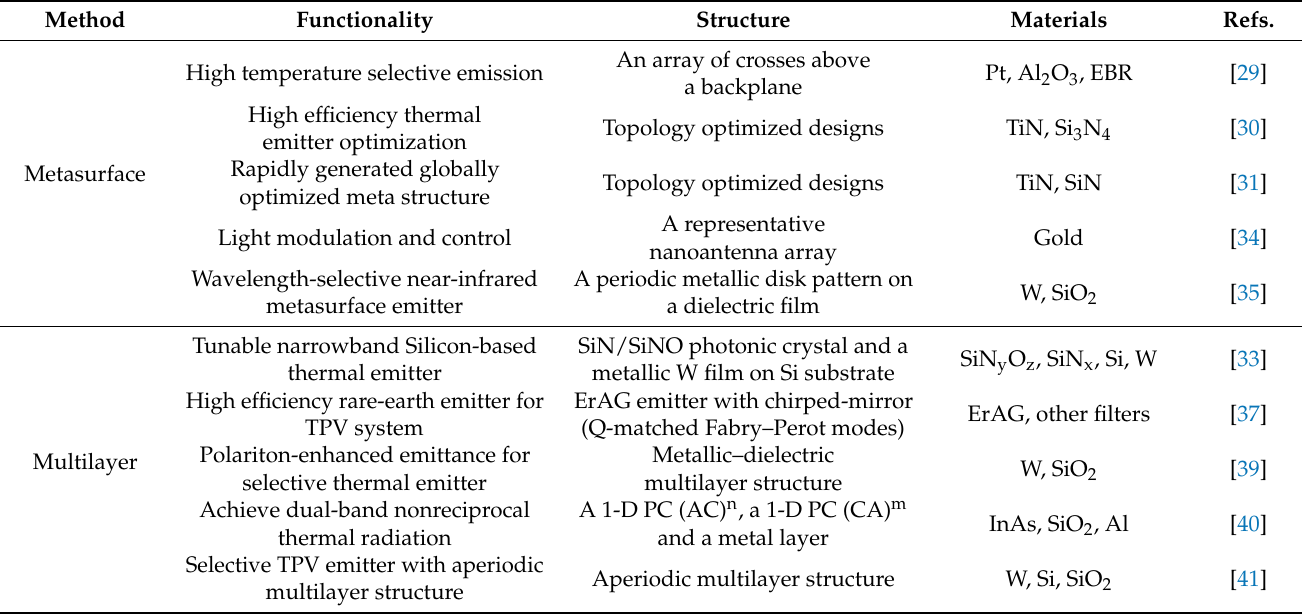
Table 1. Two common design methods together with relevant